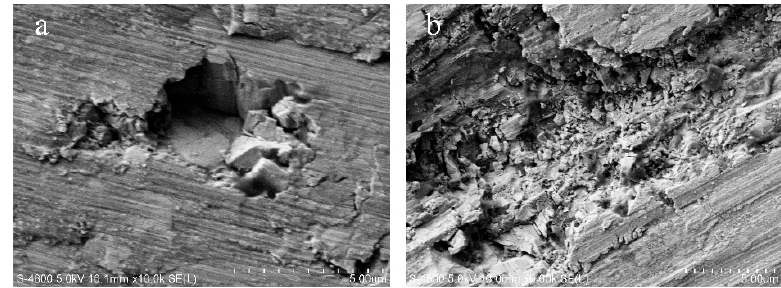
Figure 7. The brittle damages on surface morphology. ( a ) Micro-pit; ( b ) large pit.